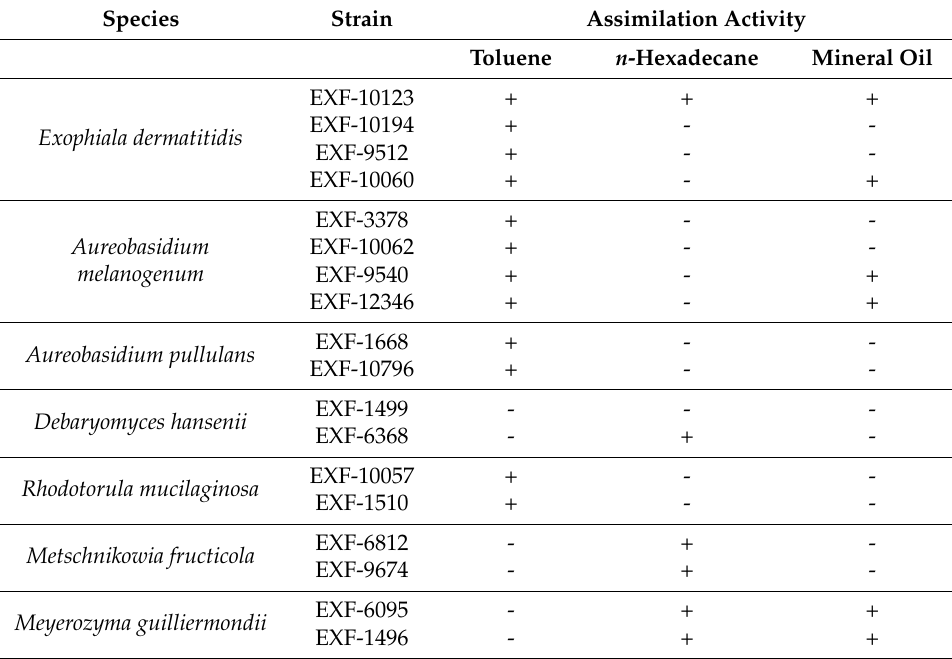
Table 4. Assimilation of the hydrocarbons by the selected yeast strains. Species Strain Assimilation